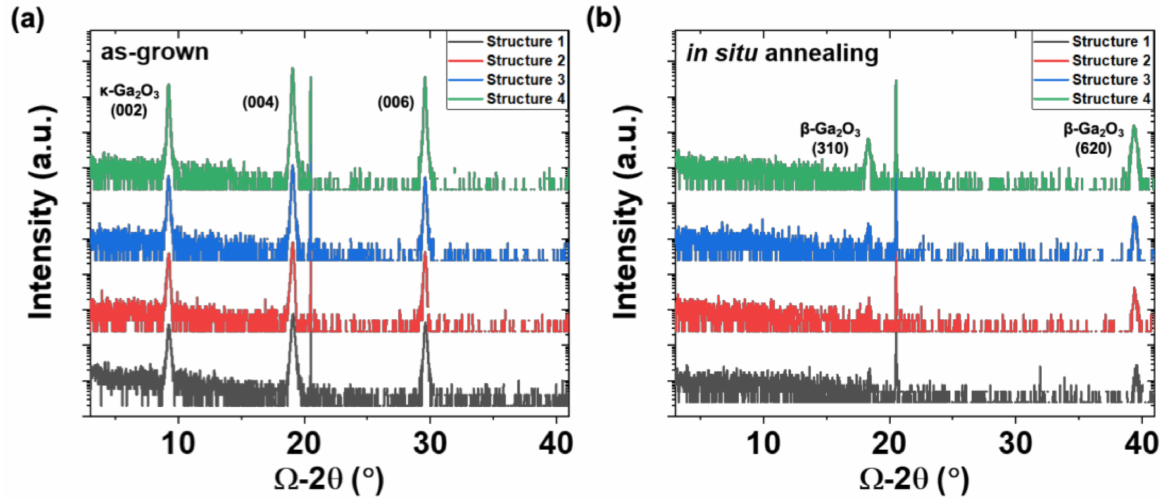
Figure 2. XRD patterns from the various ( a ) as-grown superlattice structures and ( b ) the annealed samples listed in Table